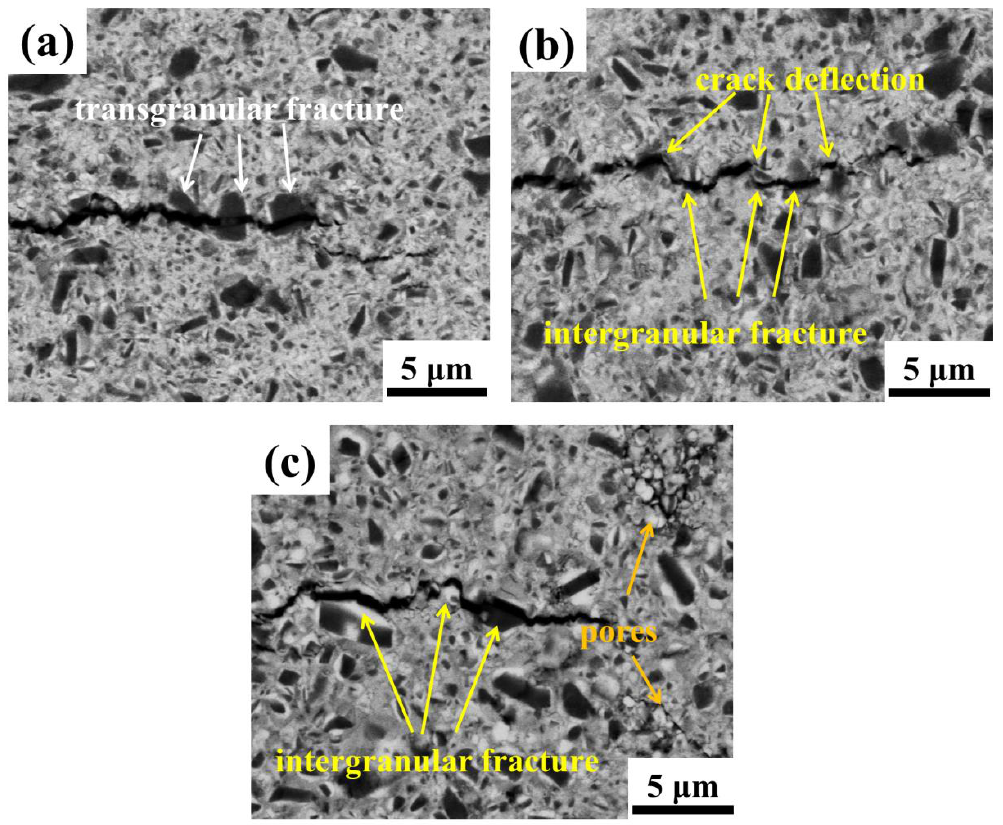
Figure 8. The crack propagation path of Ti(C,N)-based cermets with different SiC p content: ( a ) 0.0 wt.%; ( b ) 2.0 wt.%; ( c ) 3.0 wt.%.